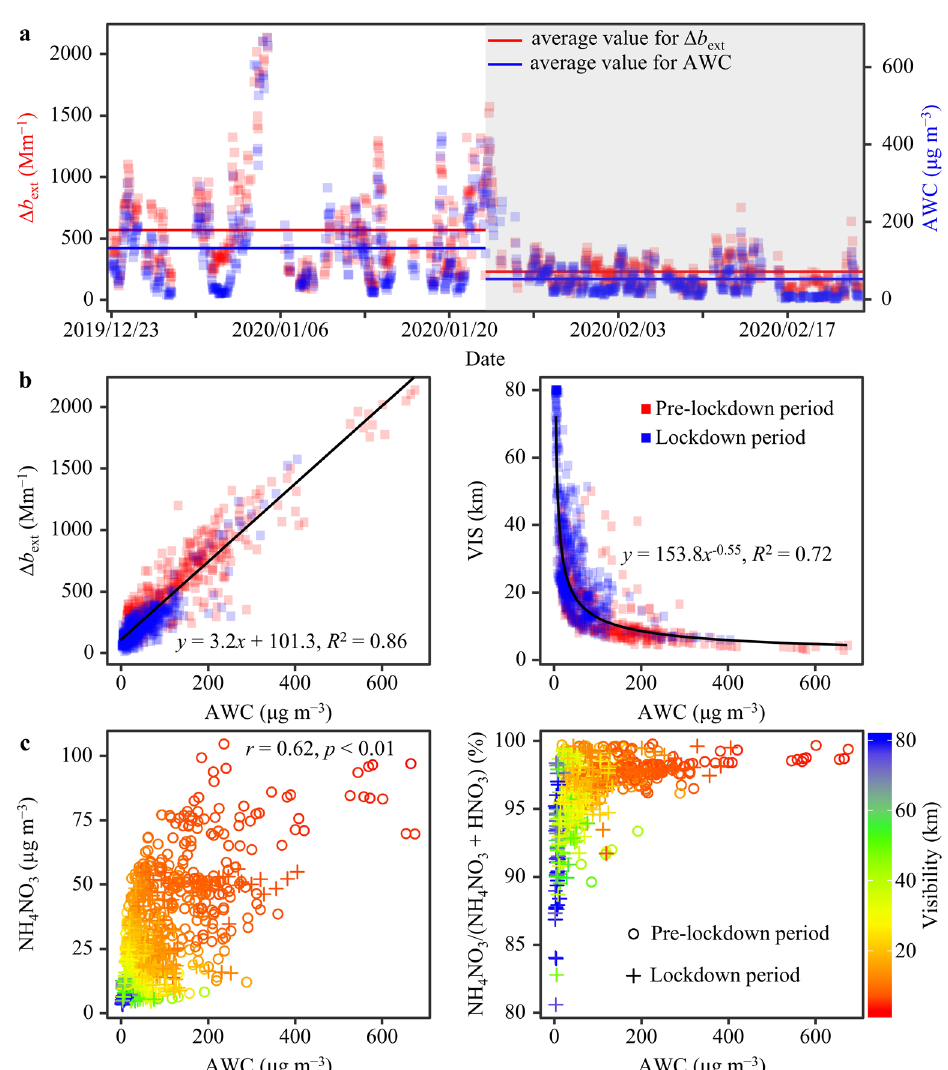
Fig. 3 Mechanisms for the further improvement of ambient visibility. a Time series of the aerosol water content (AWC) and the differences ( Δ b ext ) between ambient and measured b ext . b Scatter plots of AWC versus Δ b ext and visibility (VIS). c Scatter plots of AWC versus NH 4 NO 3 concentration and the mass ratio of NH 4 NO 3 /(NH 4 NO 3 + HNO 3 ). The circles and crosses are colored based on ambient